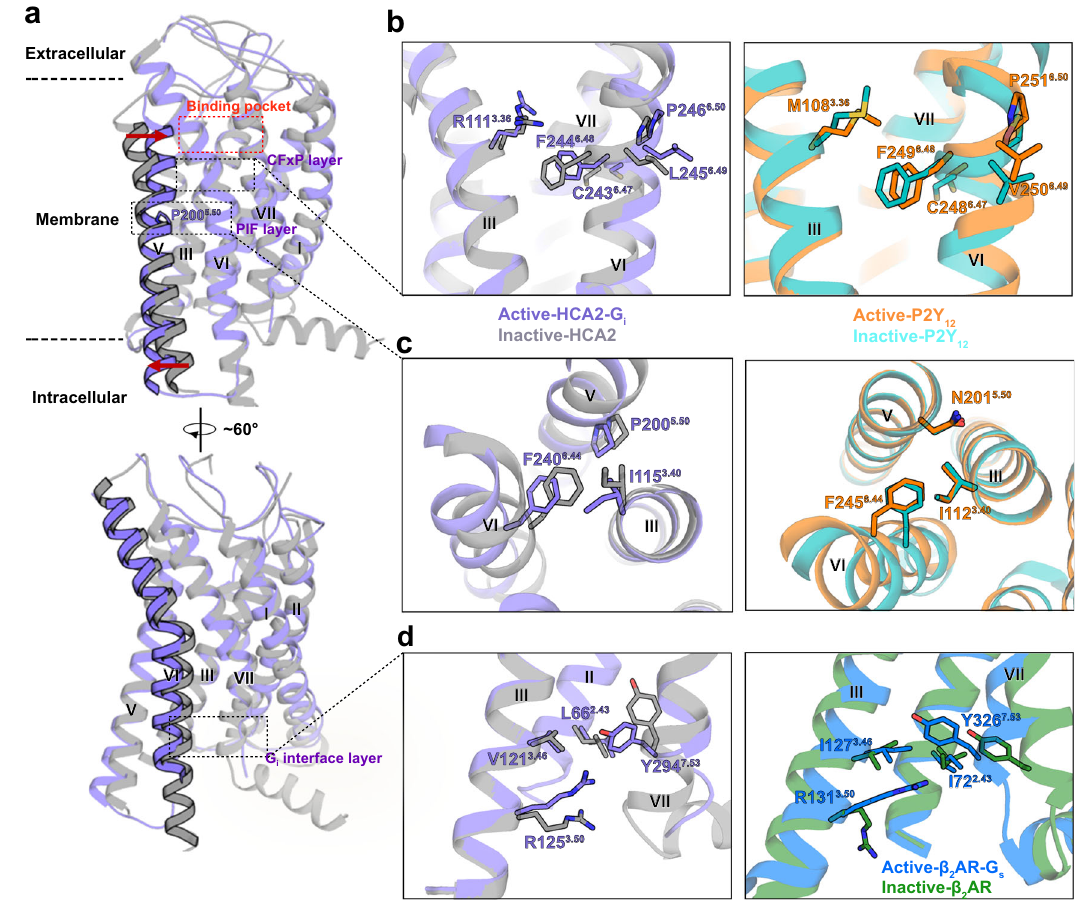
Fig. 2 | HCA2 activation and conformation changes. a Side view of active HCA2 aligned with inactive HCA2, membrane boundaries are marked as dashed lines. Signi fi cant local rotation and translation are observed on helix V and VI. b Structural comparison of CF(W)xP motif between P2Y 12 (active PDB: 4PXZ [https://doi.org/10.2210/pdb4PXZ/pdb], orange; inactive PDB: 4NTJ [https://doi. org/10.2210/pdb4NTJ/pdb],teal)andHCA2(active:lightpurple;apo:grey)inactive